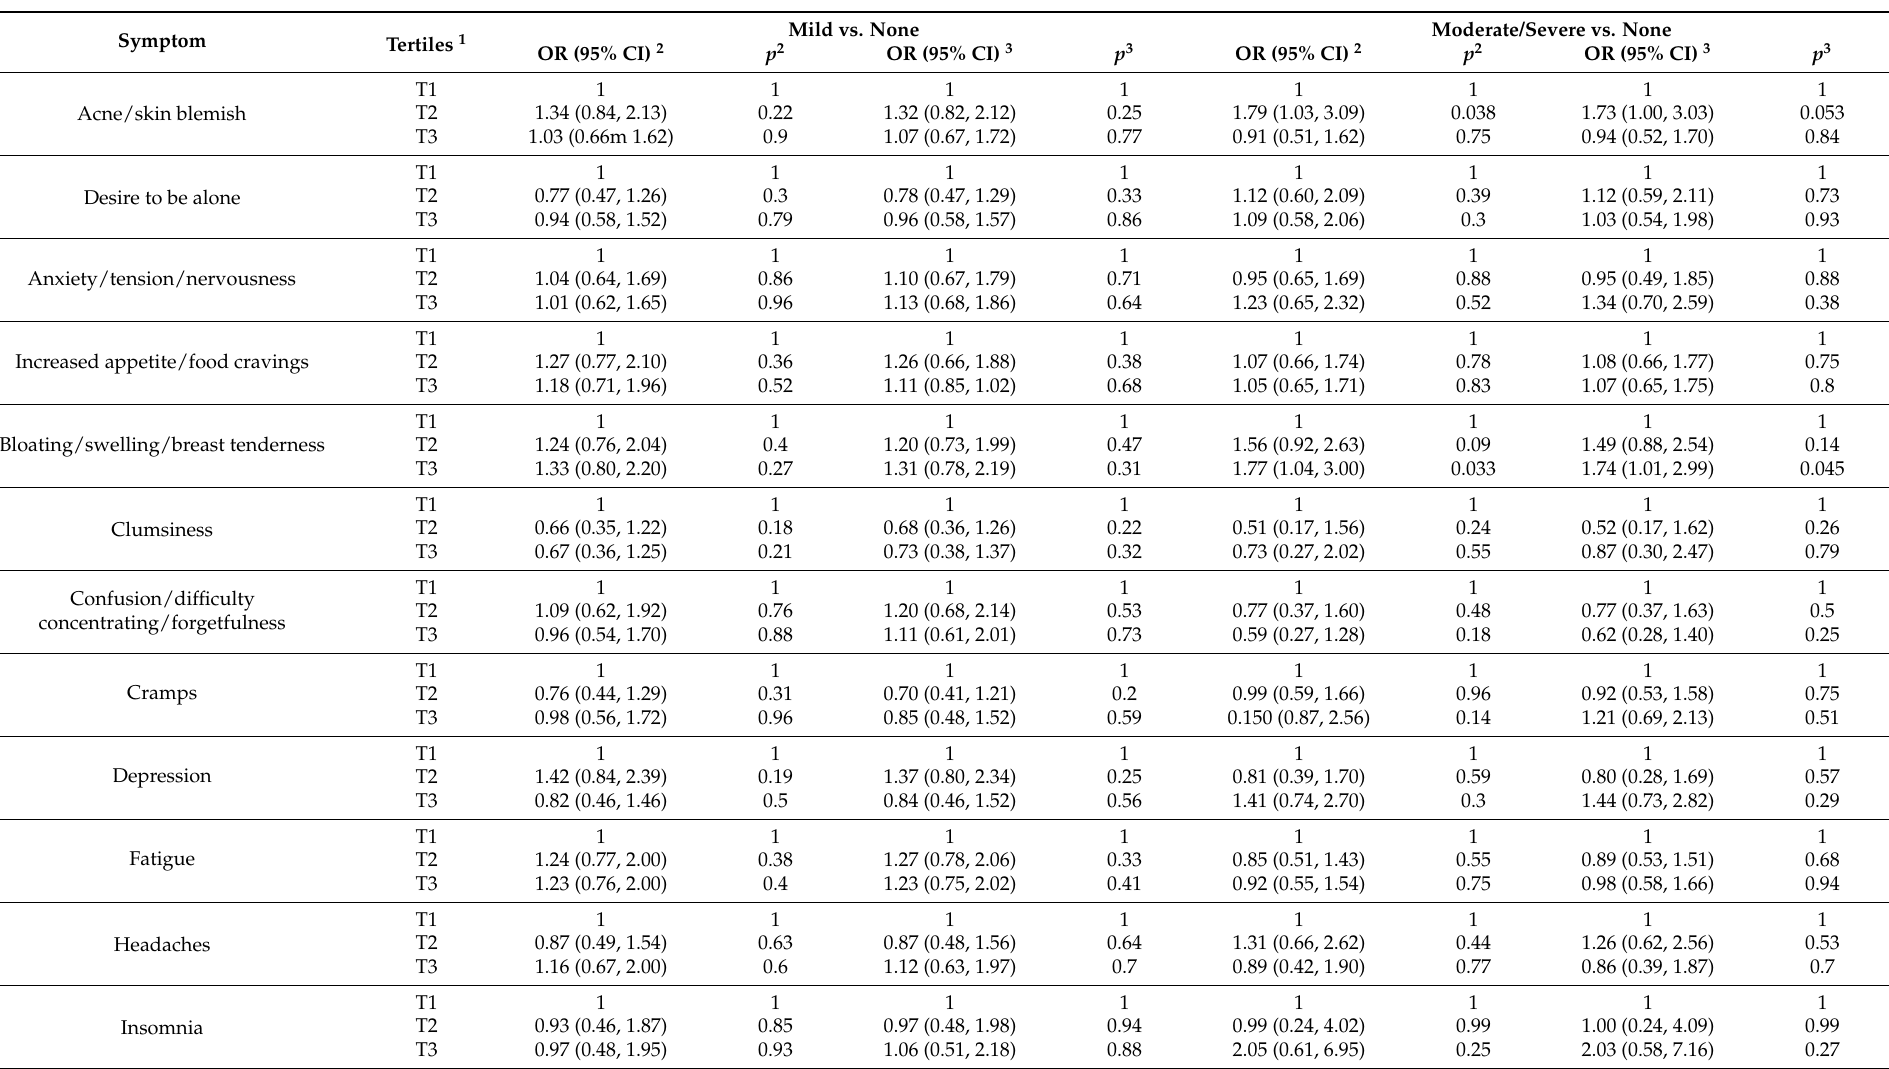
Table 8. Unadjusted and adjusted Odds Ratios and 95% CIs for the association between tertiles of plasma trans-lycopene and premenstrual symptoms.